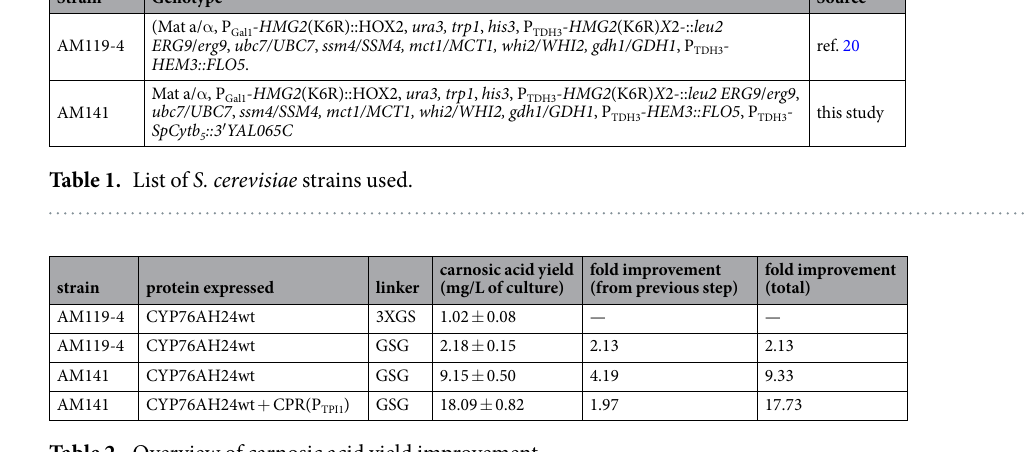
Table 2. Overview of carnosic acid yield